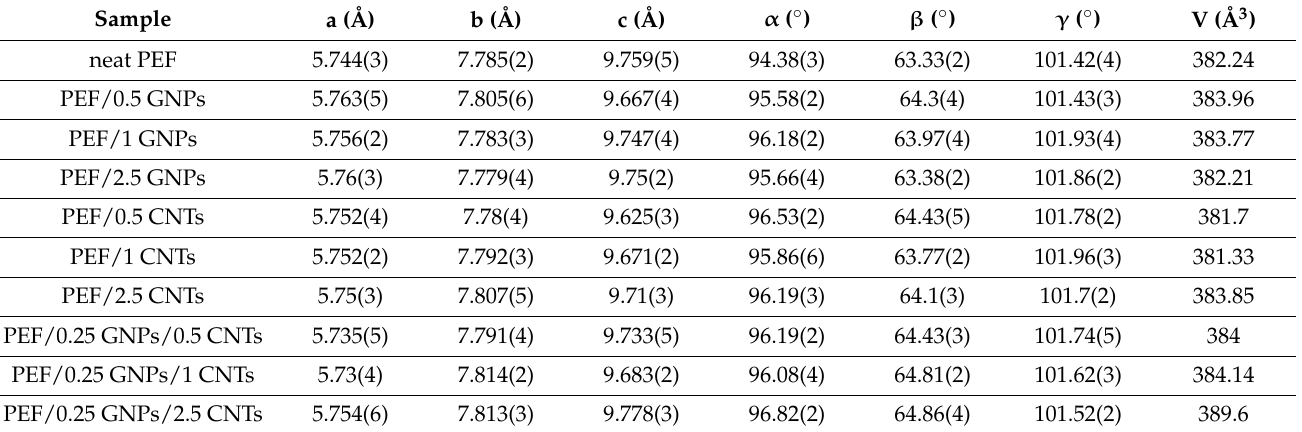
Table 3. Calculated unit cell parameters of neat PEF and PEF/Carbon fillers nanocomposites. The estimated standard deviation is written in